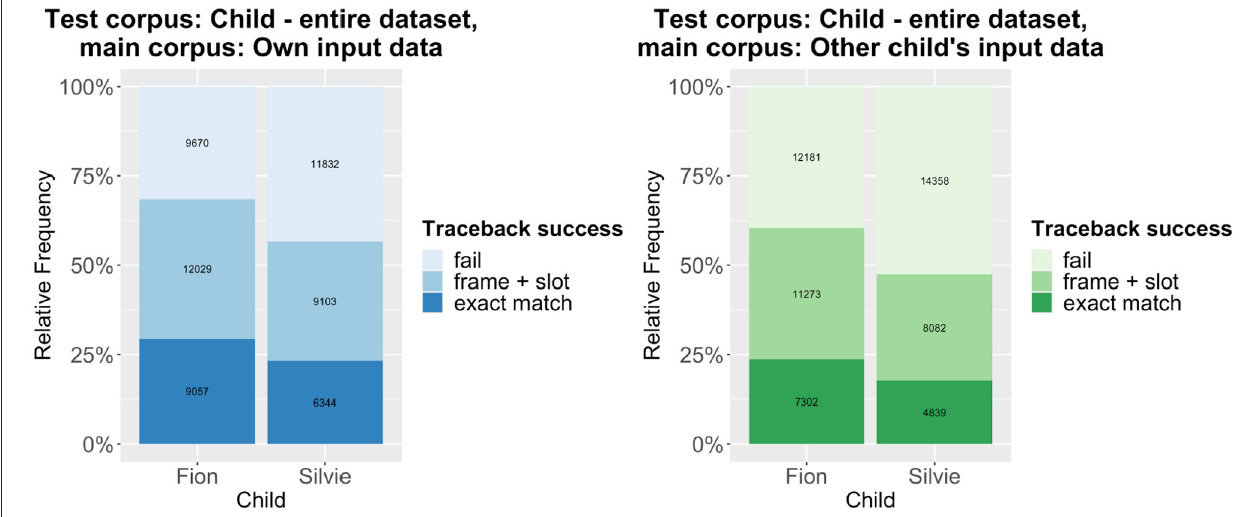
FIGURE 3 | Traceback results using all utterances of each child as test corpus and the caregivers’ utterances (left) or the other child’s caregivers’ utterances (right) as main corpus.